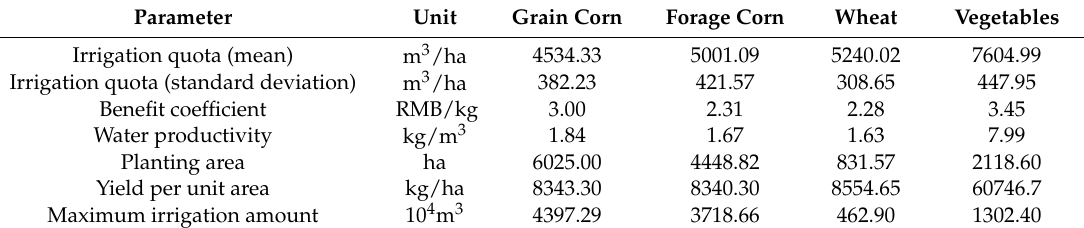
Table 4. Parameters for crops.